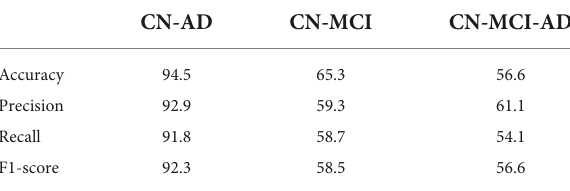
TABLE 2 Classification scores for three classification tasks using the ADNI